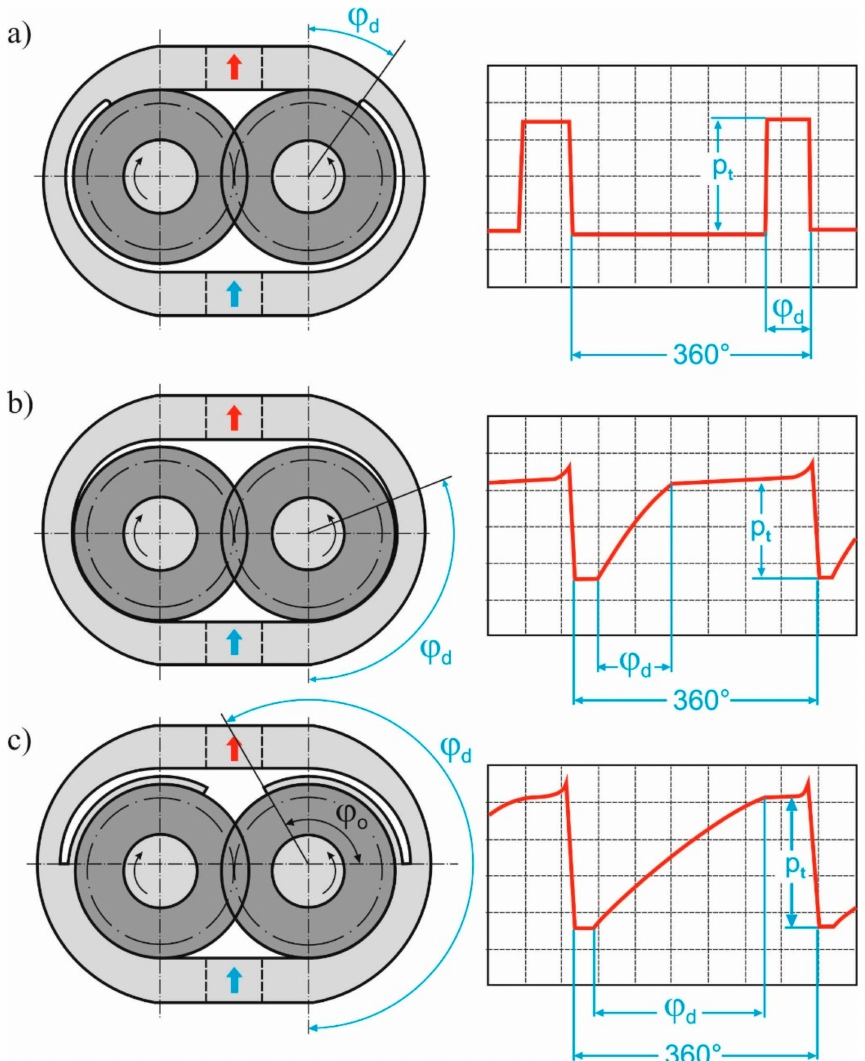
Figure 1. Schematic diagram of circumferential gear sealing together with the changes of the circumferential pressure measured in the tooth space as a function of the rotation angle of the gear: ( a ) pump with radial backlash compensation, ( b ) pump with gears shifted from the hydrostatic pressure of the liquid, ( c ) pump with circumferential backlash compensation. Indications: ϕ o— wrapping angle, ϕ d— caulk angle, P t— discharge (output) pressure